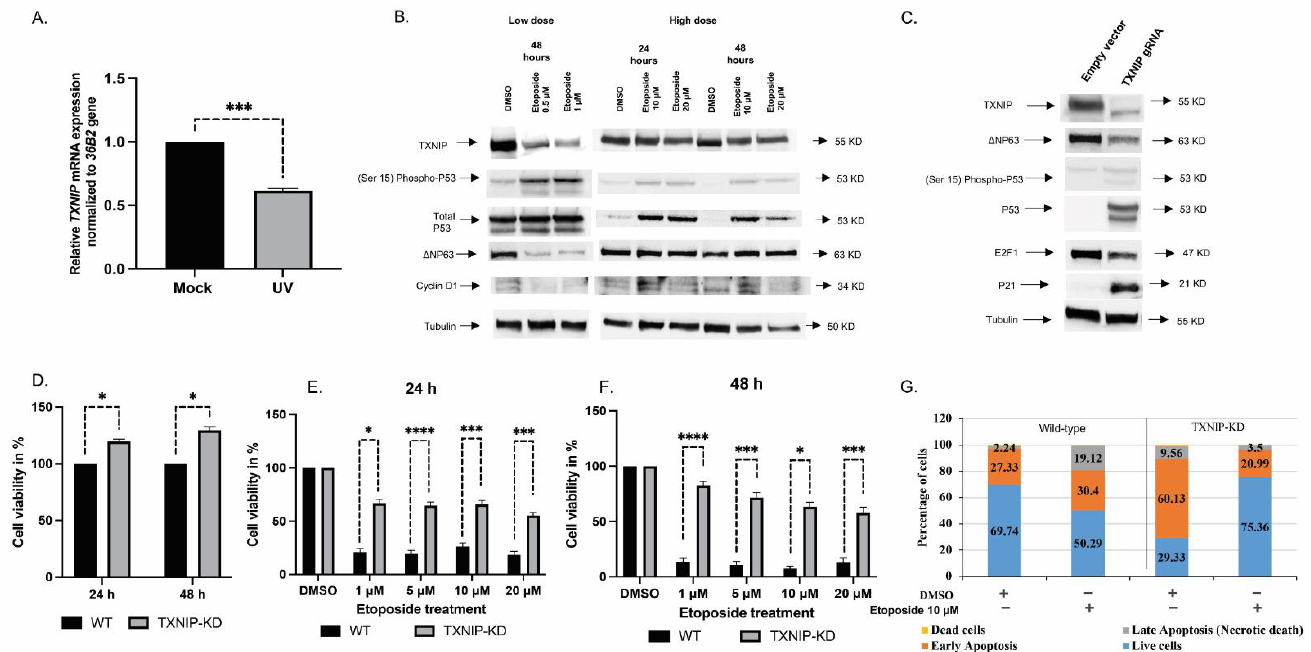
Figure 1. Analysis of the role of TXNIP in the DNA damage response. ( A ) Primary normal fibroblast cells (3 individual cell lines) were irradiated with UV (50 mjoule/cm), or left untreated, and harvested at 6 h for RT-QPCR analysis. *** p < 0.001 vs. respective untreated cells. ( B ) HEK293t cells were stimulated with low (0.5 μM and 1 μM) or high (10 μM and 20 μM) doses of etoposide for 24 or 48 h. After separation by SDS-PAGE, protein levels of TXNIP, P53, phospho-P53 (phosphorylated at serine 15), ΔNP63 and Cyclin D1 were determined using immunoblotting. Tubulin served as a loading control. Results shown are means ± S.D. of two independent experiments with duplicate samples. ( C ) HEK293t cells were maintained in full medium and transfected with a CRISPR/Cas9 plasmid containing a gRNA for the TXNIP gene (or non-targeting gRNA). Cells were sorted based on the expression of GFP. At the end of the incubation period, cells were harvested and lysed as described in Section 2. Lysates (100 µg) were analyzed by Western blotting for TXNIP, P53, phospho-P53 (phosphorylated at serine 15), P21, Cyclin D1, E2F1 and ∆ NP63. Levels of tubulin were measured as a loading control. ( D ) TXNIP-KD HEK293t and wild-type cells were seeded in 96-well plates (3000 cells/well; four replicates) for 24 or 48 h, after which cell proliferation was assessed by XTT assays. A value of 100% was given to the cell number of wild-type cells. The experiment was repeated three times with similar results. ( E , F ) TXNIP-KD HEK293t and wild-type cells were treated with increasing doses of etoposide for 24 ( E ) or 48 ( F ) h, after which cell viability was measured by XTT assays. A value of 100% was given to the number of cells of DMSO-treated cultures. Shown is a typical experiment repeated three times with similar results. * p -value ≤ 0.05; *** p -value ≤ 0.001; **** p -value ≤ 0.0001 ( G ) Etoposide-treated wild-type and TXNIP-KD HEK293t cells were analyzed by flow cytometry to distinguish between apoptotic and necrotic cell death. Annexin V FITC/PI staining was used to assess the mode of cell